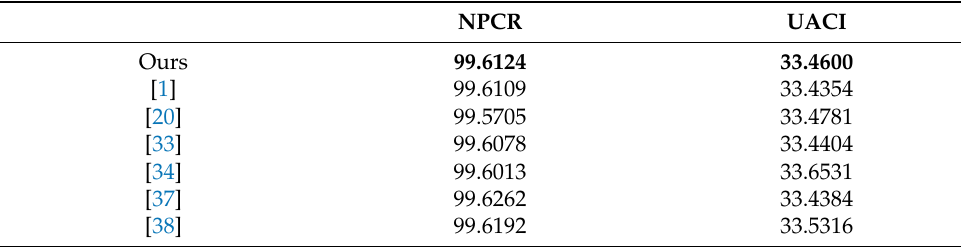
Table 4. The comparison between the different algorithms for the plaintext